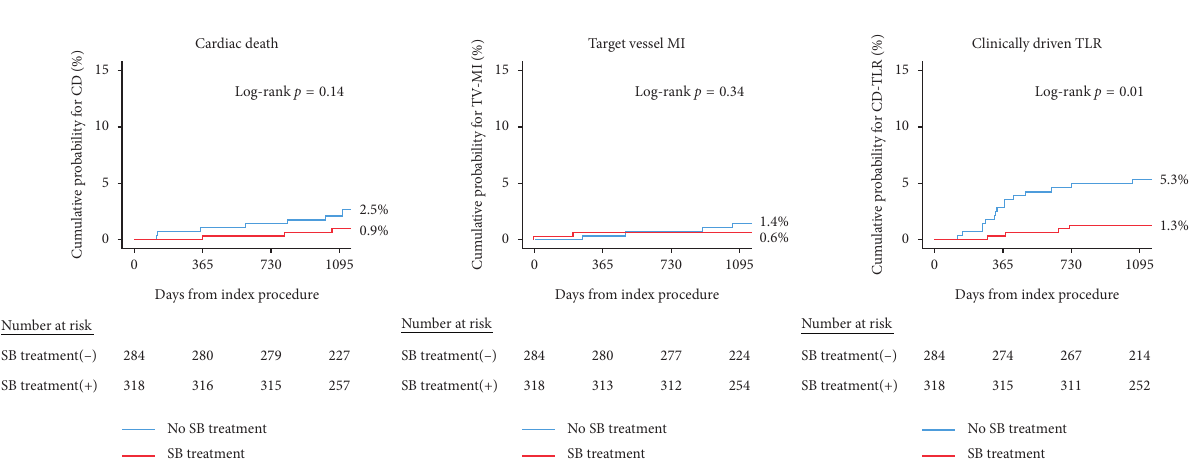
Figure 3: Kaplan–Meier curve for 3-year individual outcomes according to side-branch treatment in the ACEF-LOW group. MI, myocardial infarction; TLR, target lesion revascularization; and SB, side branch; ACEF, age, creatinine, and ejection fraction score.